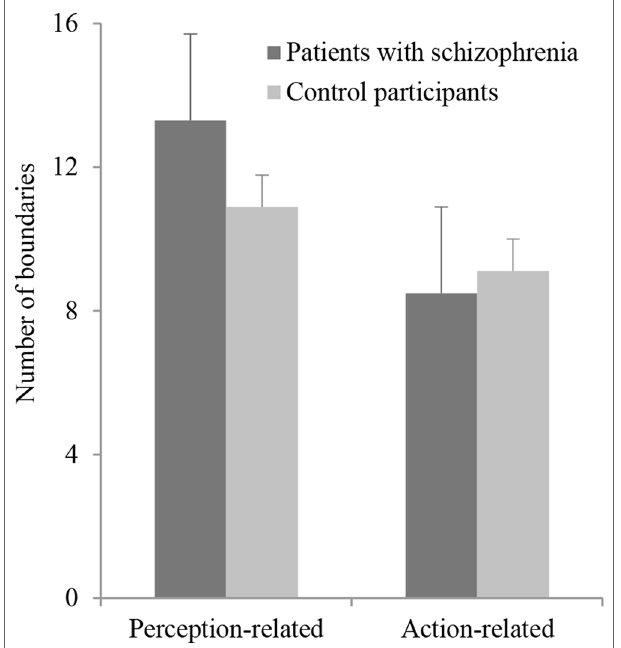
FIGURE 2 | Mean number of boundaries for perception-related and action-related segmentation, in both patient and control groups. Error bars represent the standard errors of the means.